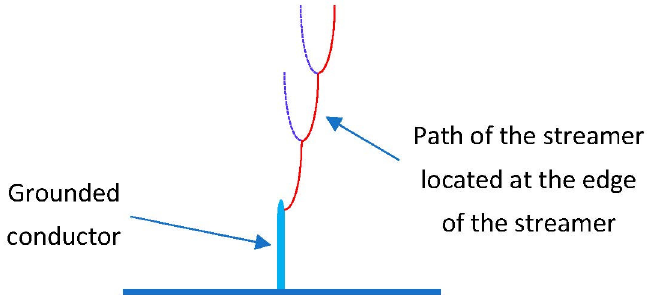
Figure 3. Illustrating the procedure (exaggerated) used to identify the outer edge of the streamer region. It is assumed that whenever the streamer branches, one of the branches is always directed away from the axis of the conductor.